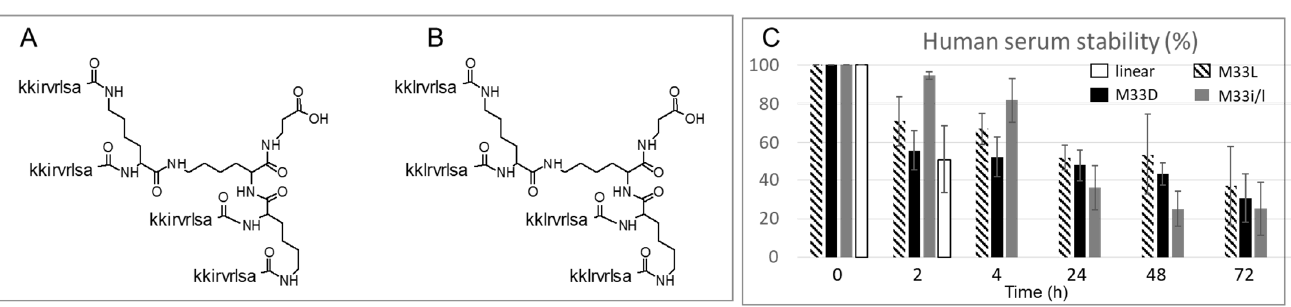
Figure 1. Structure of the branched antimicrobial peptides, M33D ( A ) and M33i/l ( B ). ( C ) Stability of the two tetrabranched peptides to serum proteolytic activity compared to a linear homolog, KKIRVRLSA, and to a branched analog in L configuration, M33L [18].